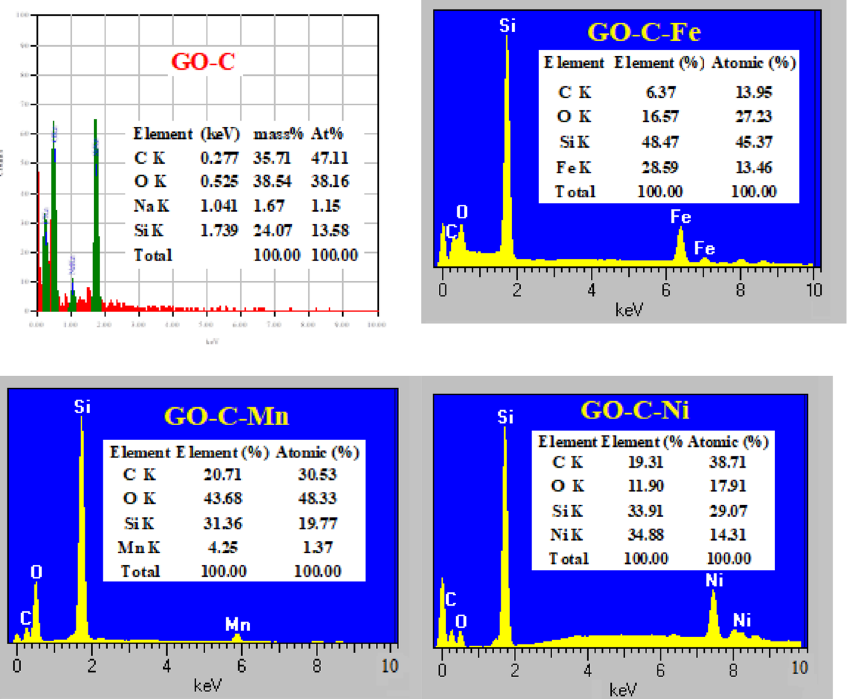
Figure 3. EDX analysis for GO-C composite, GO-C-Ni complex, GO-C-Fe complex, and GO-C-Mn